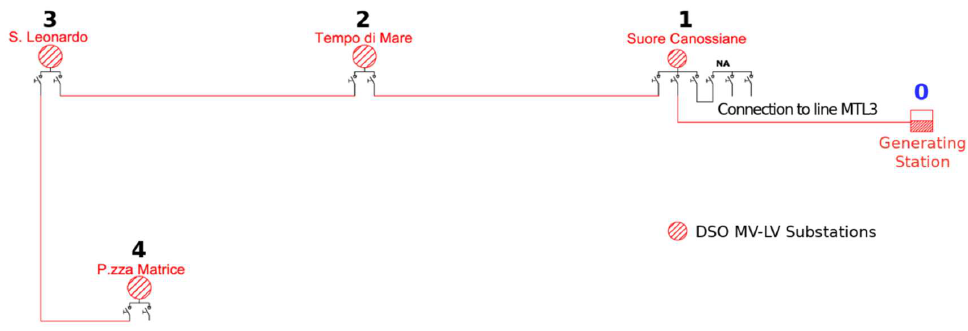
Figure 5. Electrical scheme of the feeder “MT L1” of the Favignana MV distribution network.